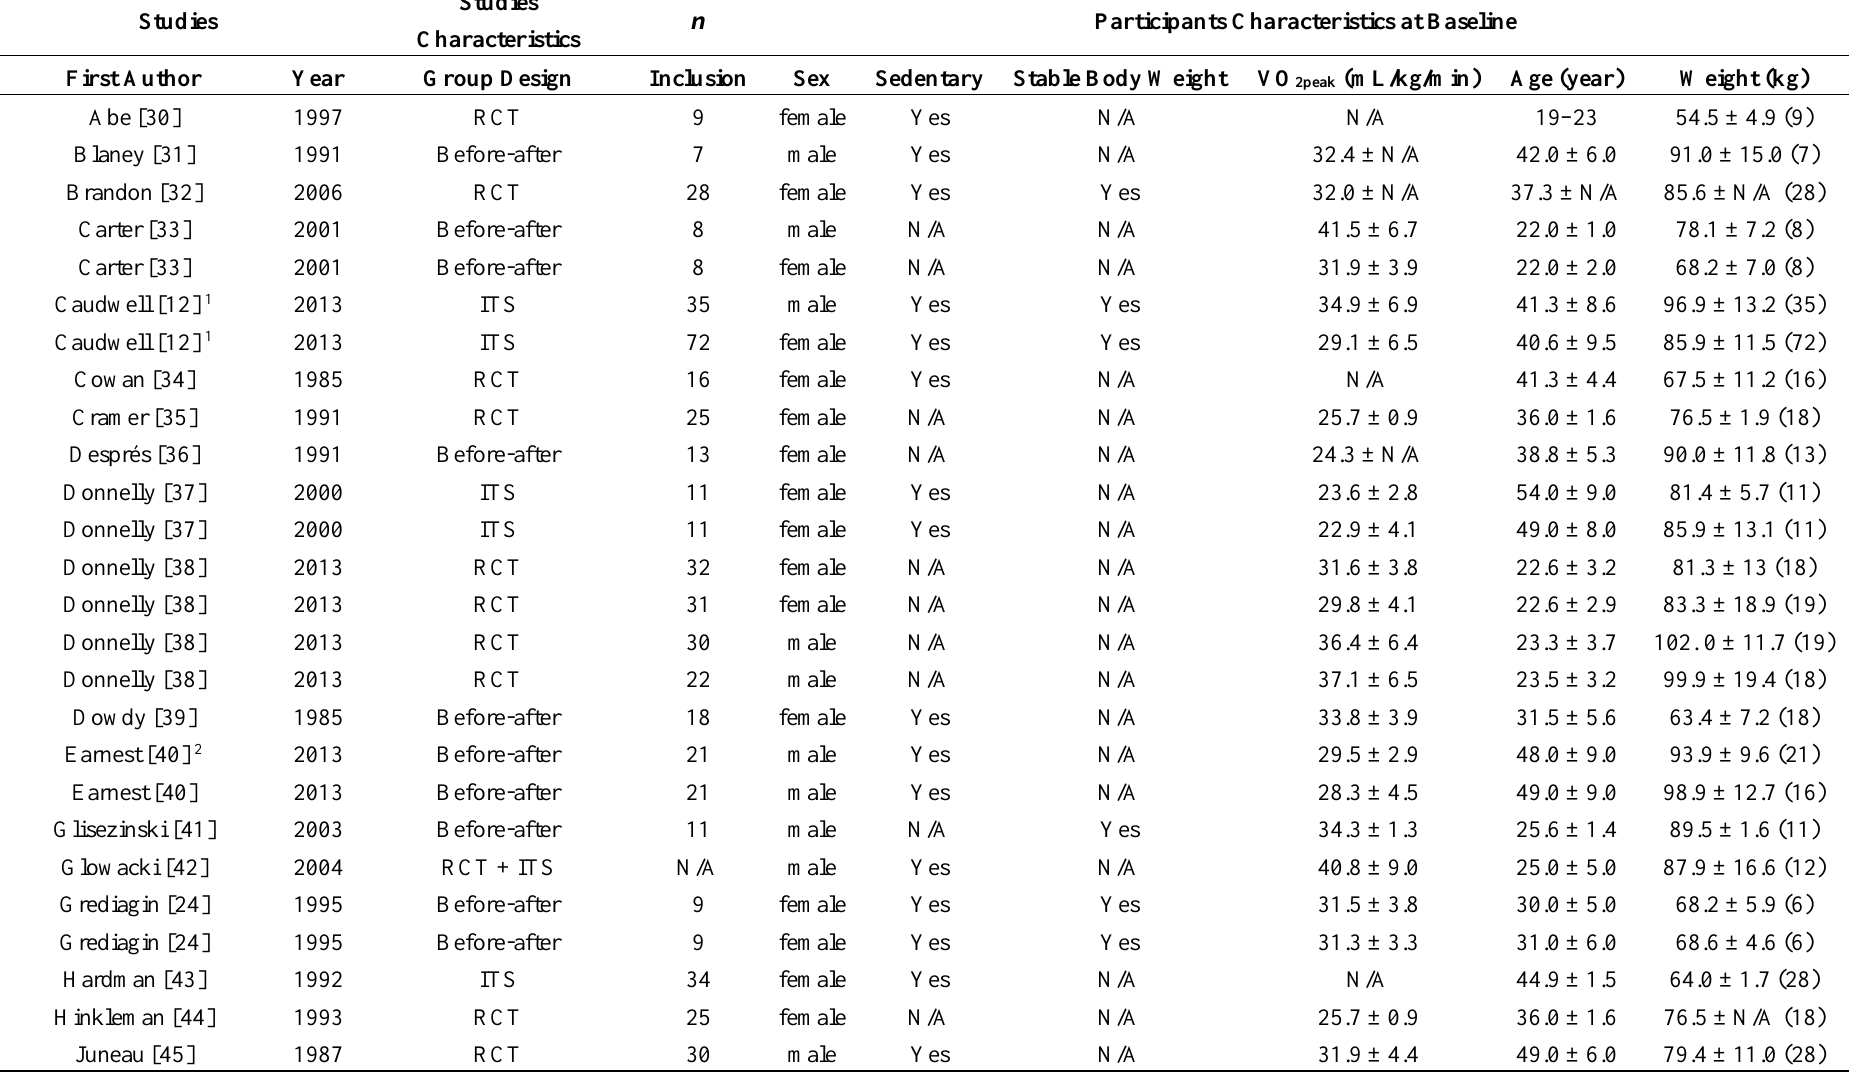
Table 2. Characteristics of included studies and baseline participants ( n =